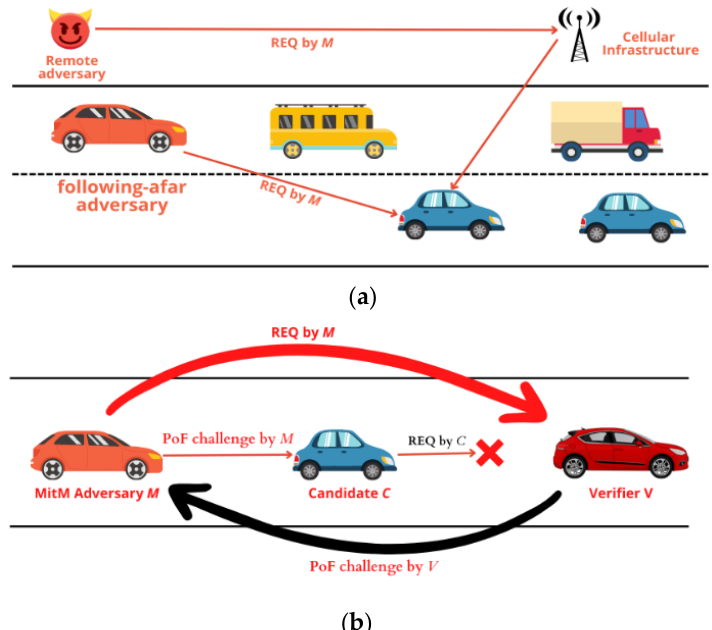
Figure 2. The threat model. ( a ) a remote adversary; ( b ) an MiTM